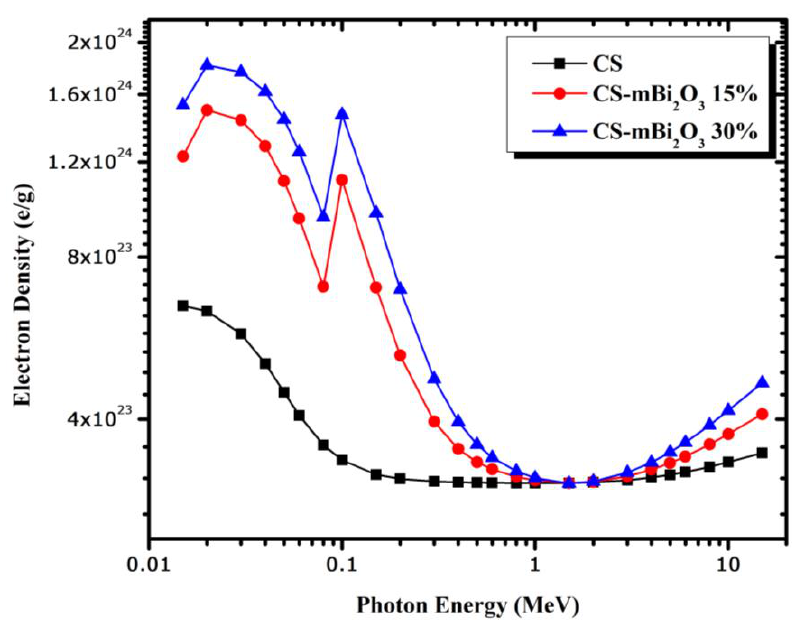
Figure 9. The variation of electron density (N eff ) of mortars as a function of energy. The equivalent atomic number (Z eq ) is a parameter that is utilized in the computation of the exposure buildup factor (EBF) and it describes the shielding characteristics of mortar number (Z eq ) of mortar samples for an energy range of 0.015 to 15 MeV. It is observed that